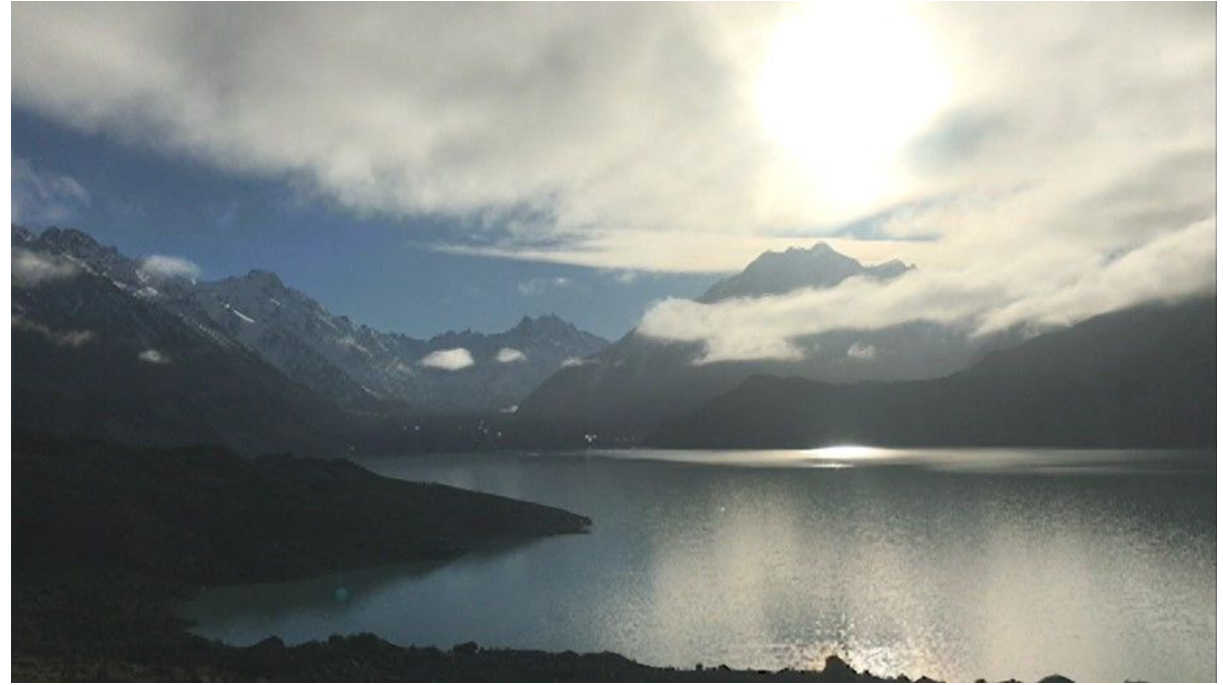
Figure 2: Video image used in tranquillity